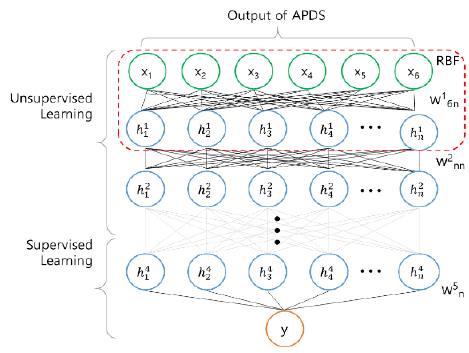
Figure 11. The structure of a neural network model in the TEDS. Algorithm 2 TDS learning algorithm